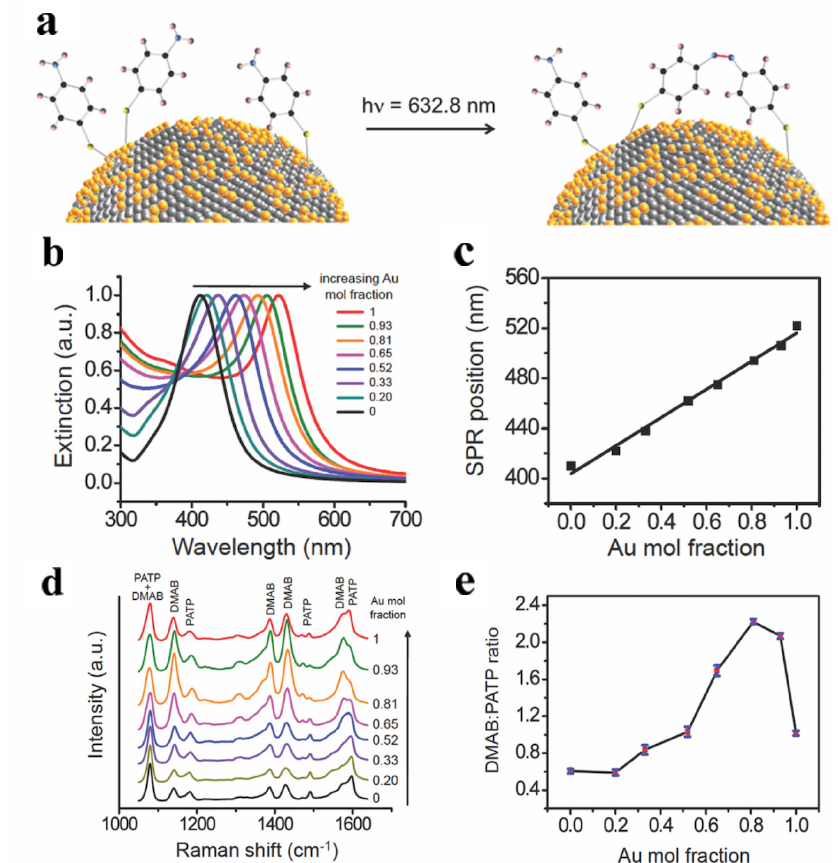
Figure 18 - a) Scheme showing the SPR-mediated oxidation of PATP to DMAB by 3 O employing AgAu nanoparticles as catalysts; b) UV-Vis extinction spectra and c) SPR peak positions as a function of the Au content (Au mole fraction) in the AgAu nanoparticles; d) SERS spectra as a function of composition (Au mole fraction) employing Ag, AgAu and Au nanoparticles functionalized with PATP; e) Obtained DMAB/PATP 1433/1593 cm -1 intensity ratios as a function of the Au content in the nanoparticles. Adapted with permission from ref. (Wang et al. 2014) Copyright 2014 American Chemical